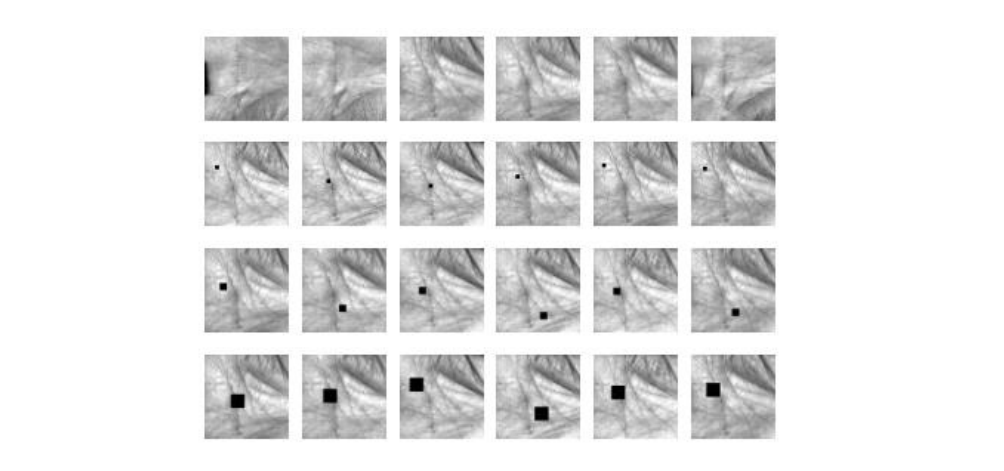
Figure 5. Partial original image and continuous occlusion image on the PolyU palmprint database. Table 1. Experimental results of recognition rate (standard deviation)(%) on PolyU palmprint database.